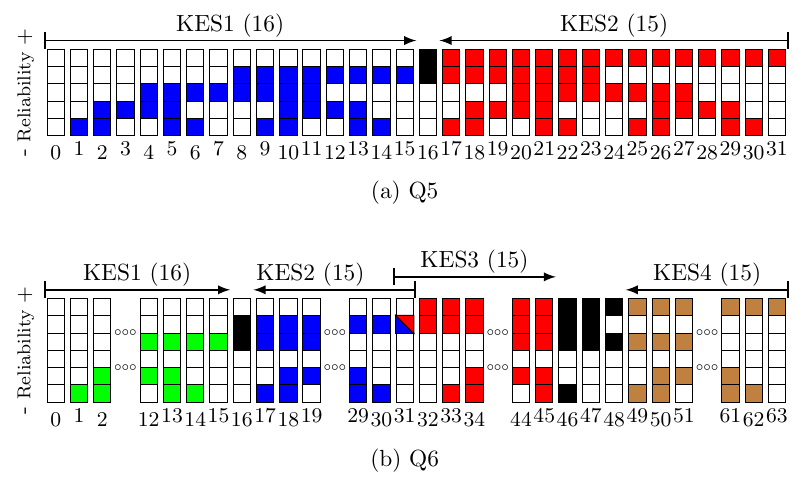
Figure 4. Test vectors used by the Q5 and Q6 decoders. The arrows show the processing order followed by each KES. ∎ = 1, ◻ =